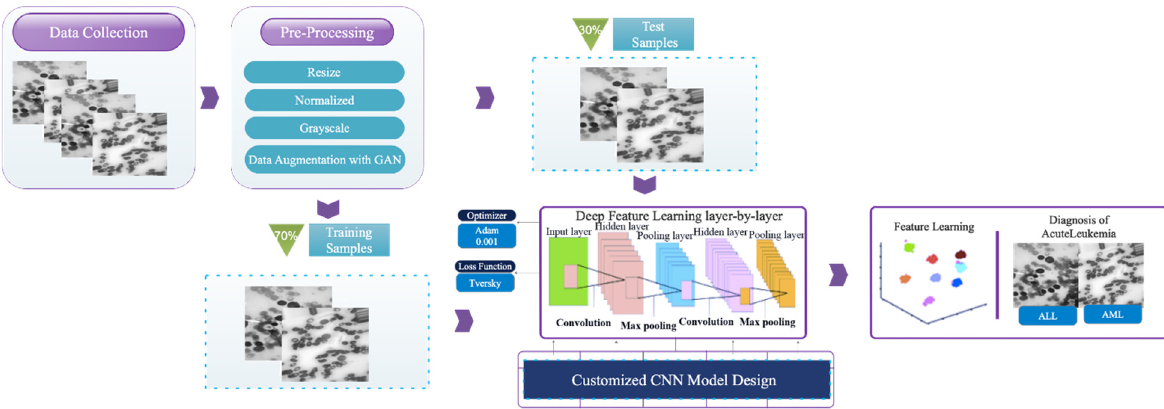
Figure 1. The graphical representation of the proposed method framework.